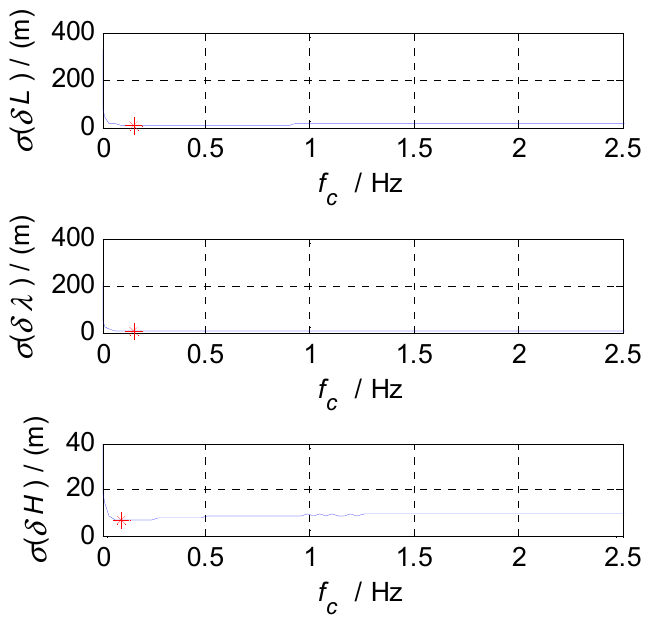
Figure 11. The relationships between f c